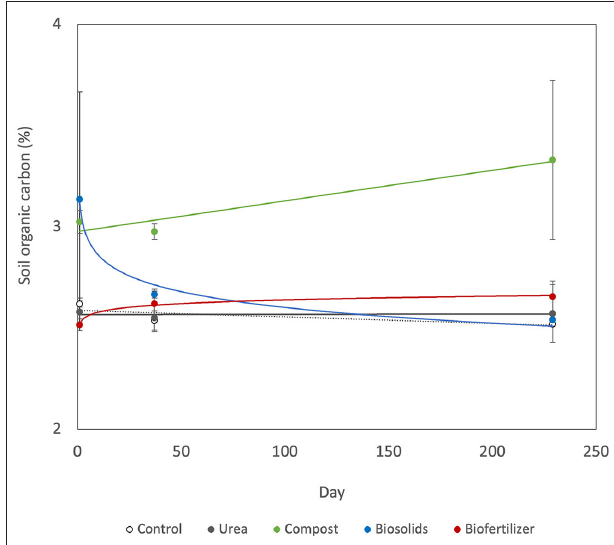
FIGURE 3 | Percent soil organic carbon immediately after adding amendments (Day 1), after the first crop cycle (Day 37), and after the sixth crop cycle (Day 239).